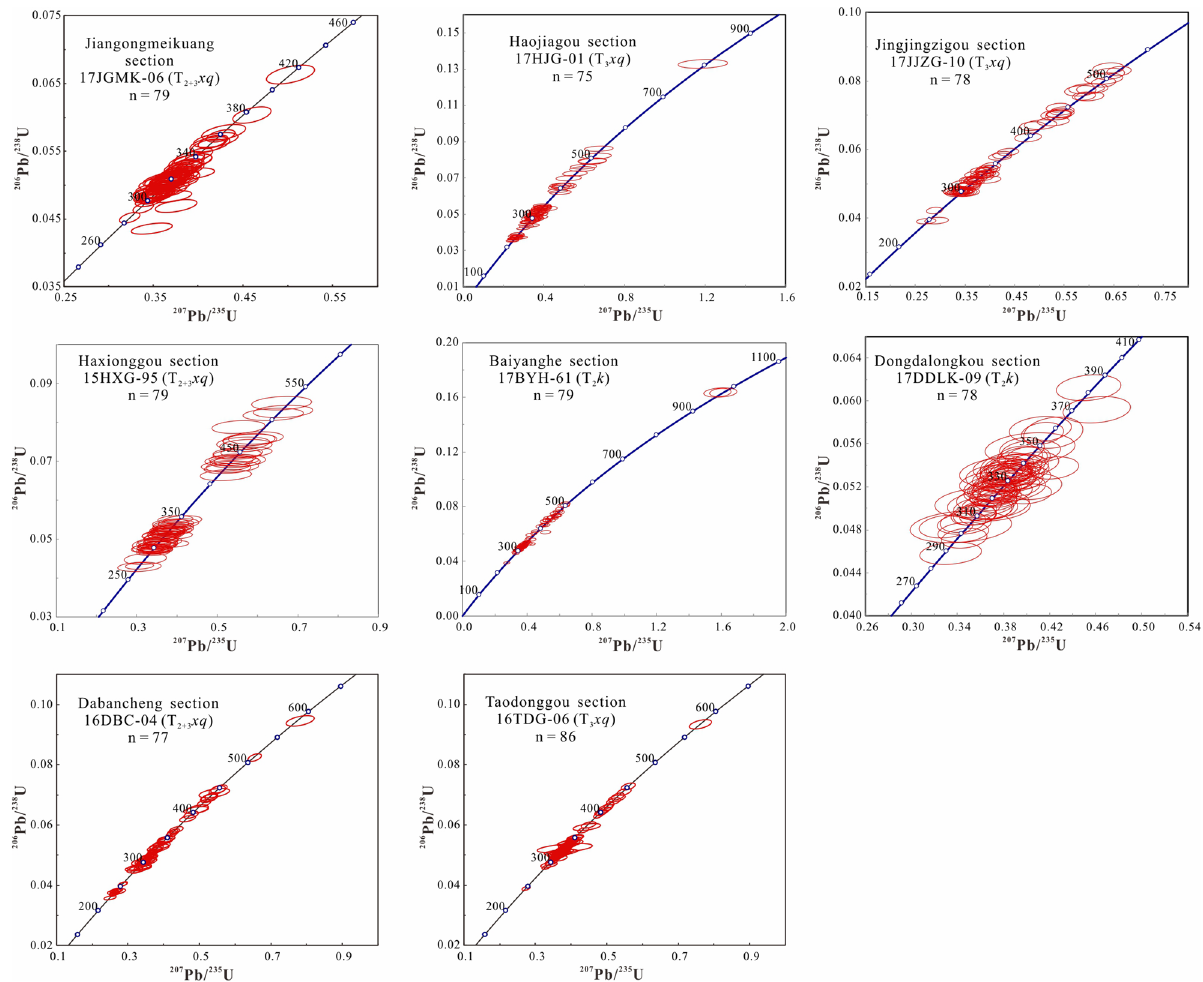
Figure 4. U–Pb concordia diagrams for zircon grains acquired from the Middle–Upper Triassic Xiaoquangou Group in different sections of the southern Junggar